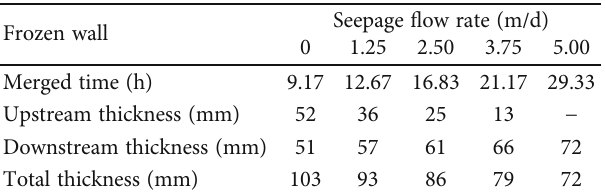
Table 2: Merged time and thickness of frozen wall in the physical